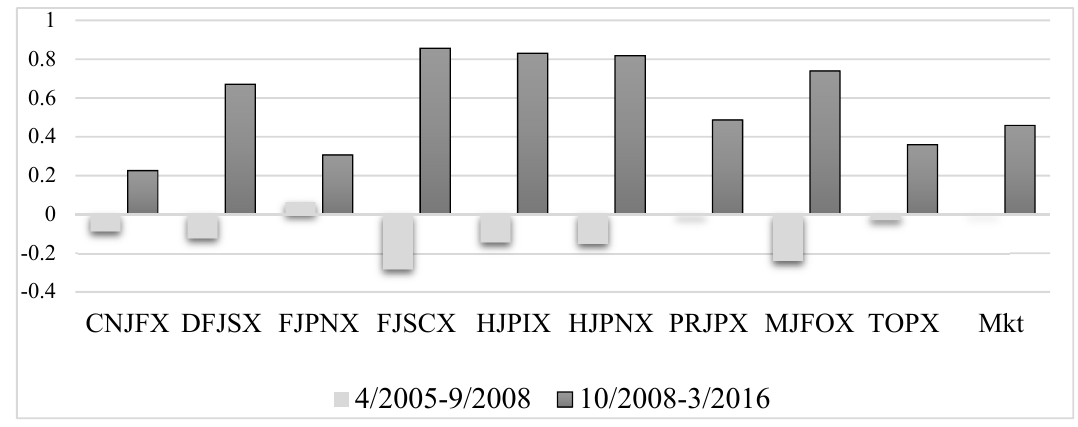
Figure 1 . Mutual funds’ cumulative returns (1 stands for 100%). Figure 1. Mutual funds’ cumulative returns (1 stands for